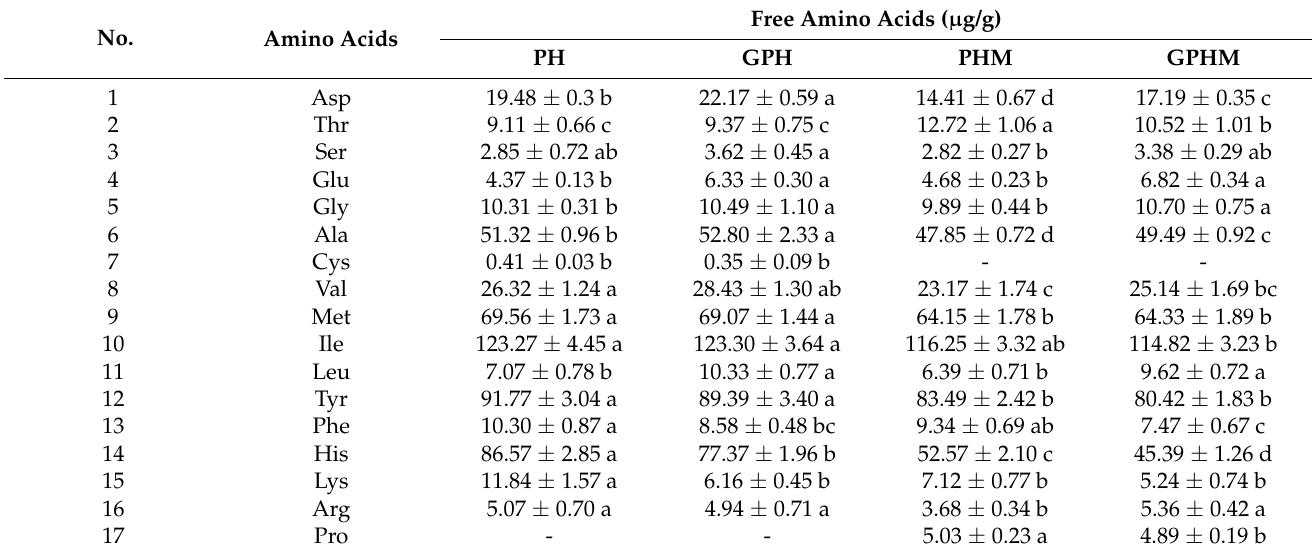
Table 2. Changes in free amino acids in the hydrolysate and the corresponding